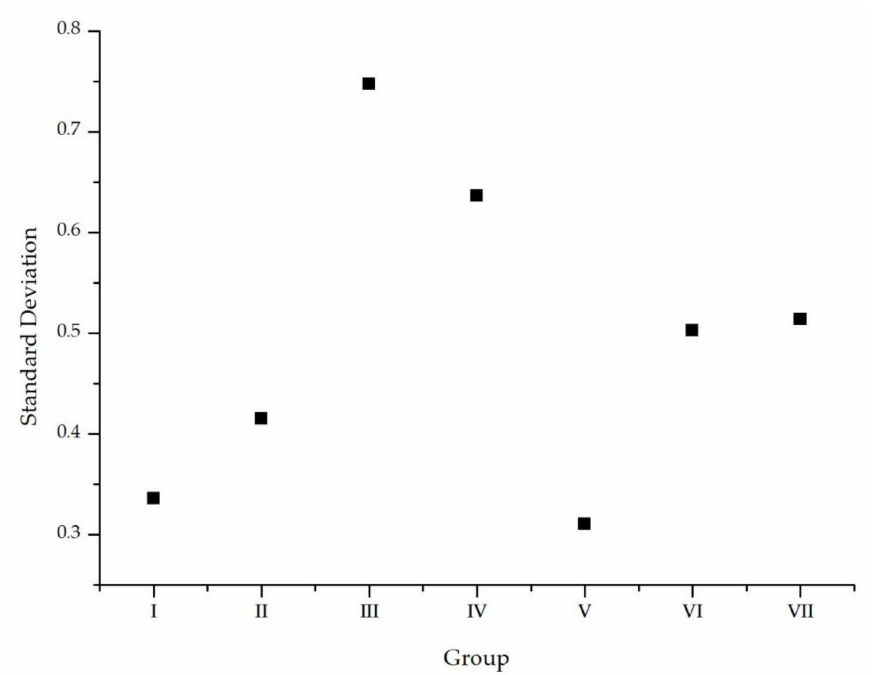
Figure 12. The standard deviation of the output power of the modules of the seven